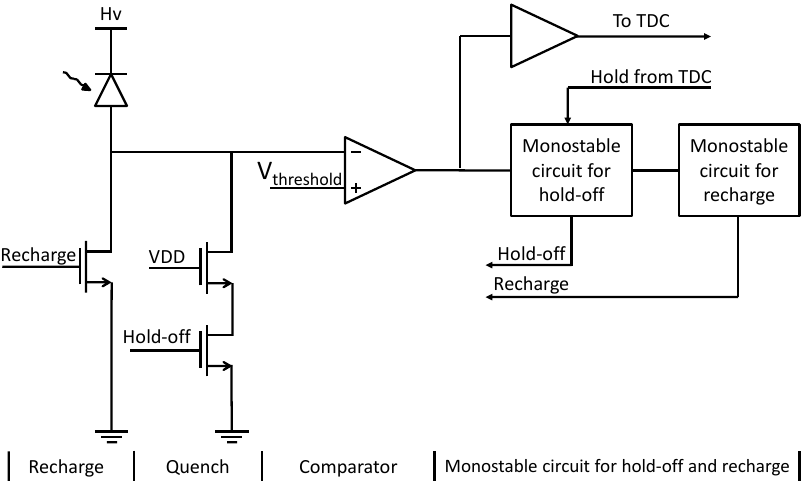
Figure 2. Overview of the SPAD and QC implemented in CMOS 65